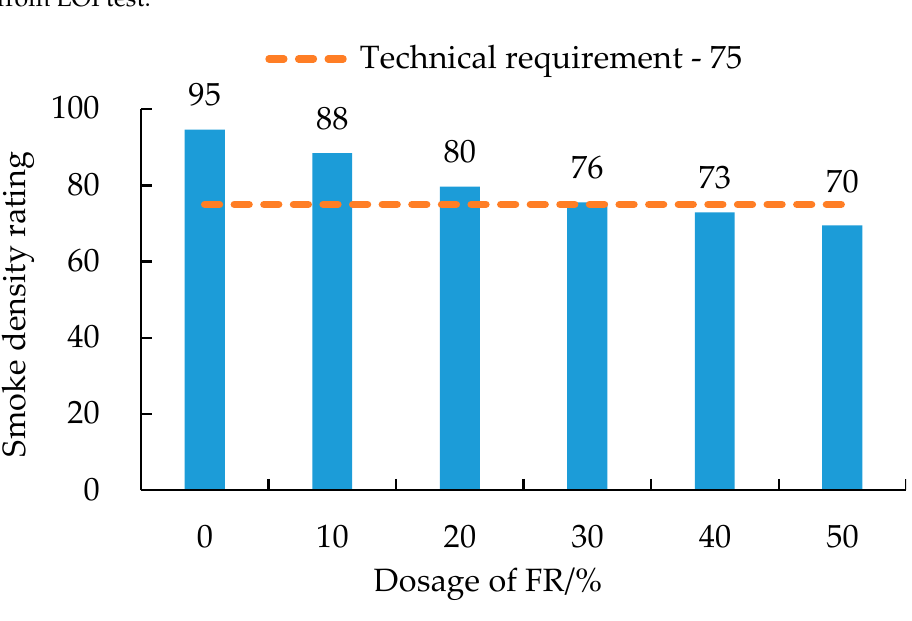
Figure 2. Smoke density rating of FRA.